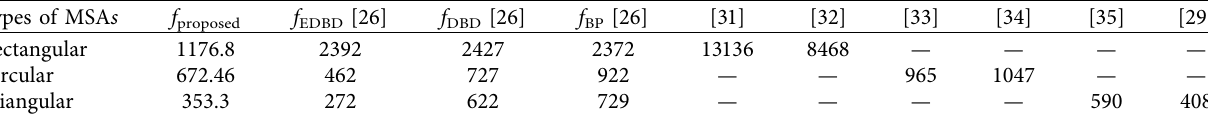
Table 8: Total absolute errors of three types of MSAs from different